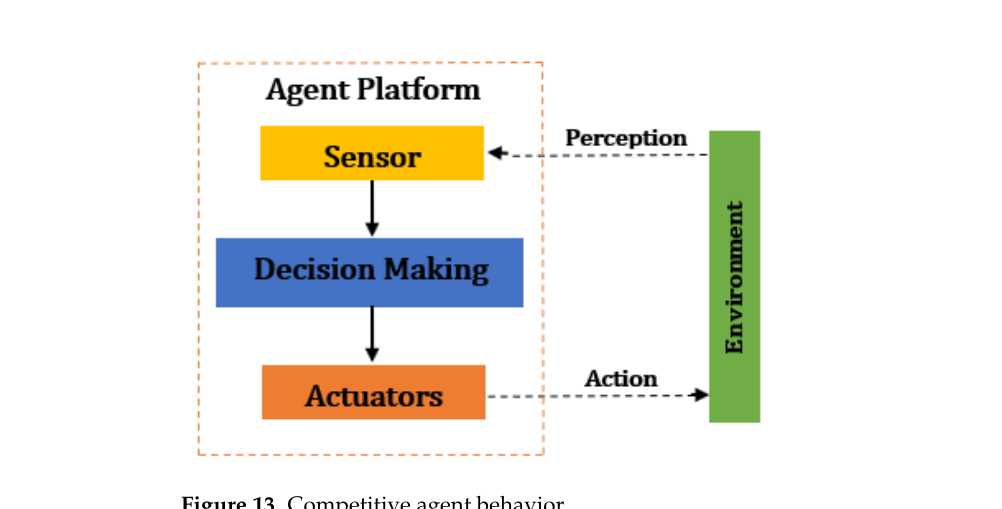
Figure 13. Competitive agent behavior.